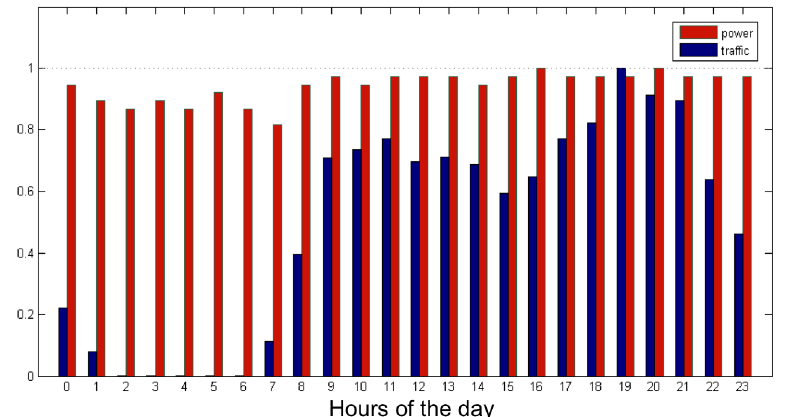
Figure 1. Power consumption and traffic of a generic public cellular base station during a